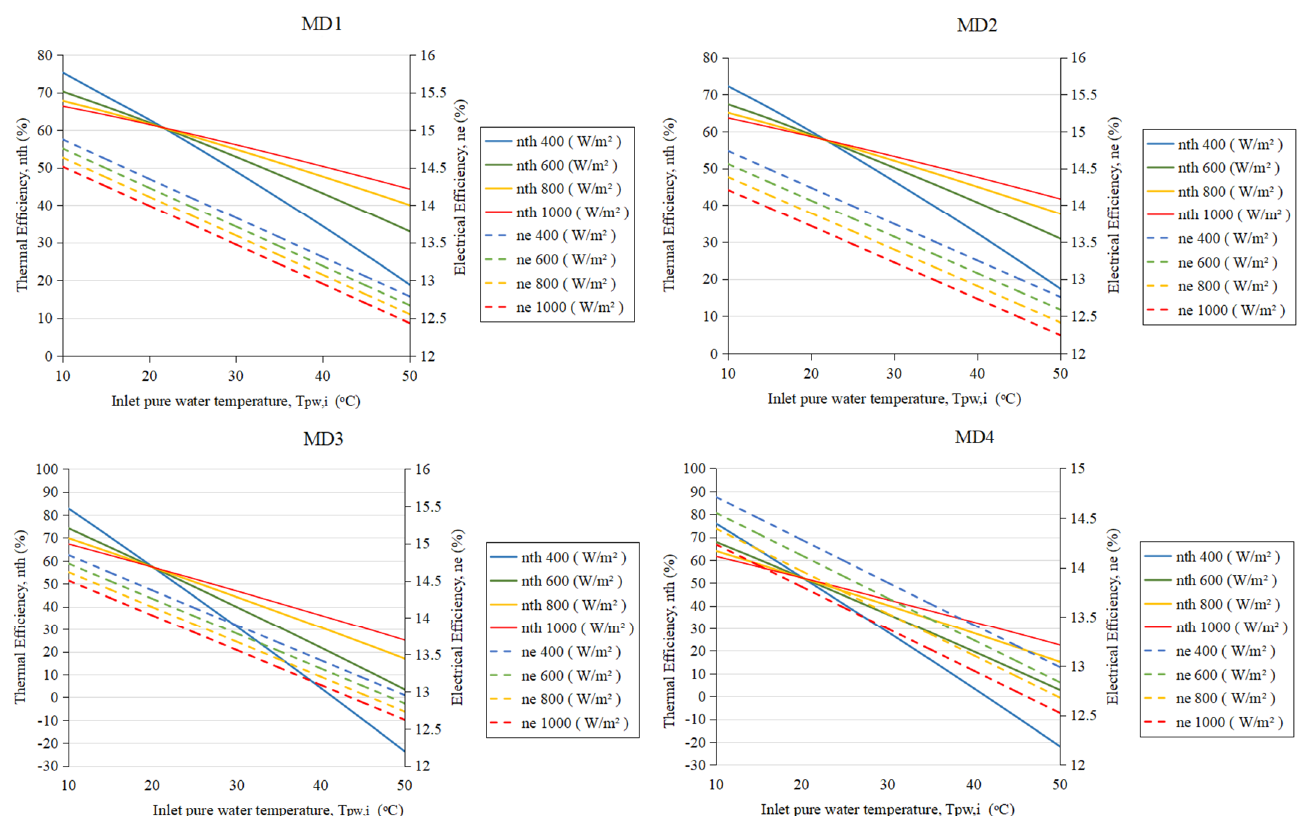
Figure 19. Thermal and electrical efficiency of four PV/T module models when changing T pw,i.